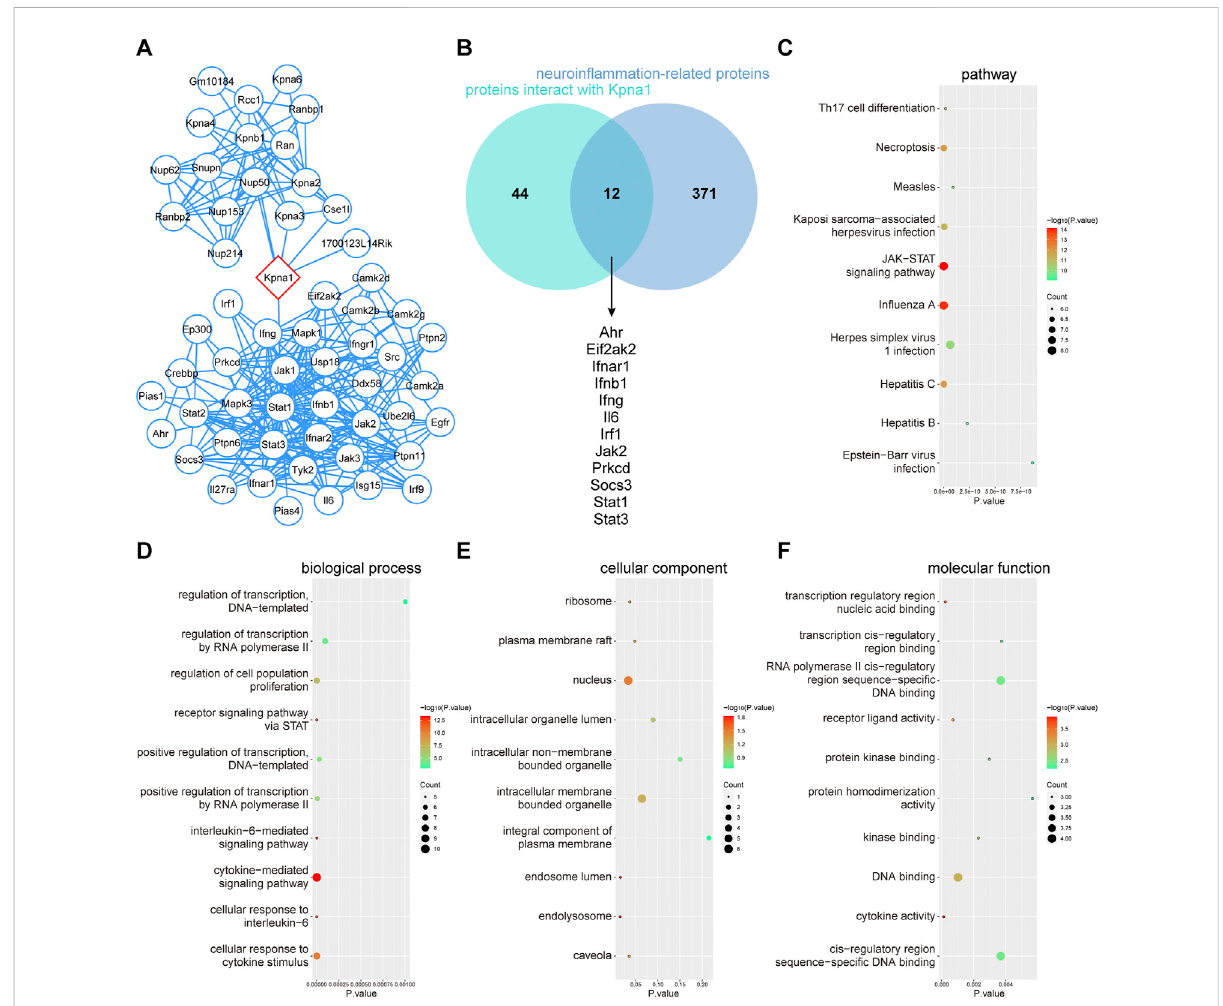
FIGURE 7 PPI network, GO terms and KEGG pathway enrichment analysis of common genes of KPNA1 and neuroin fl ammation. (A) PPI network of KPNA1 and related proteins. (B) Venn diagram of theintersection targetof KPNA1 and neuroin fl ammation. (C) KEGG pathway enrichment analysis of 12 common genes. (D – F) GO function enrichment analysis of 12 common genes. Different bubble charts of biological process (BP), cellular component (CC), and molecular function (MF). The size of each circle indicates gene count. The color of circles represents different -log10 ( p-